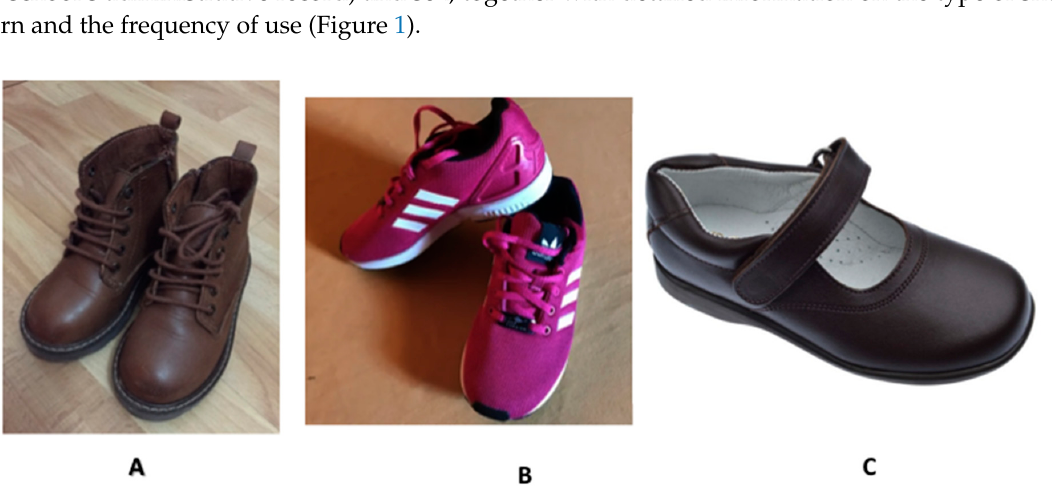
Figure 1. Classification of type of shoes used in the study: ( A ) Boot ( B ) Sport shoes ( C ) Street shoes.